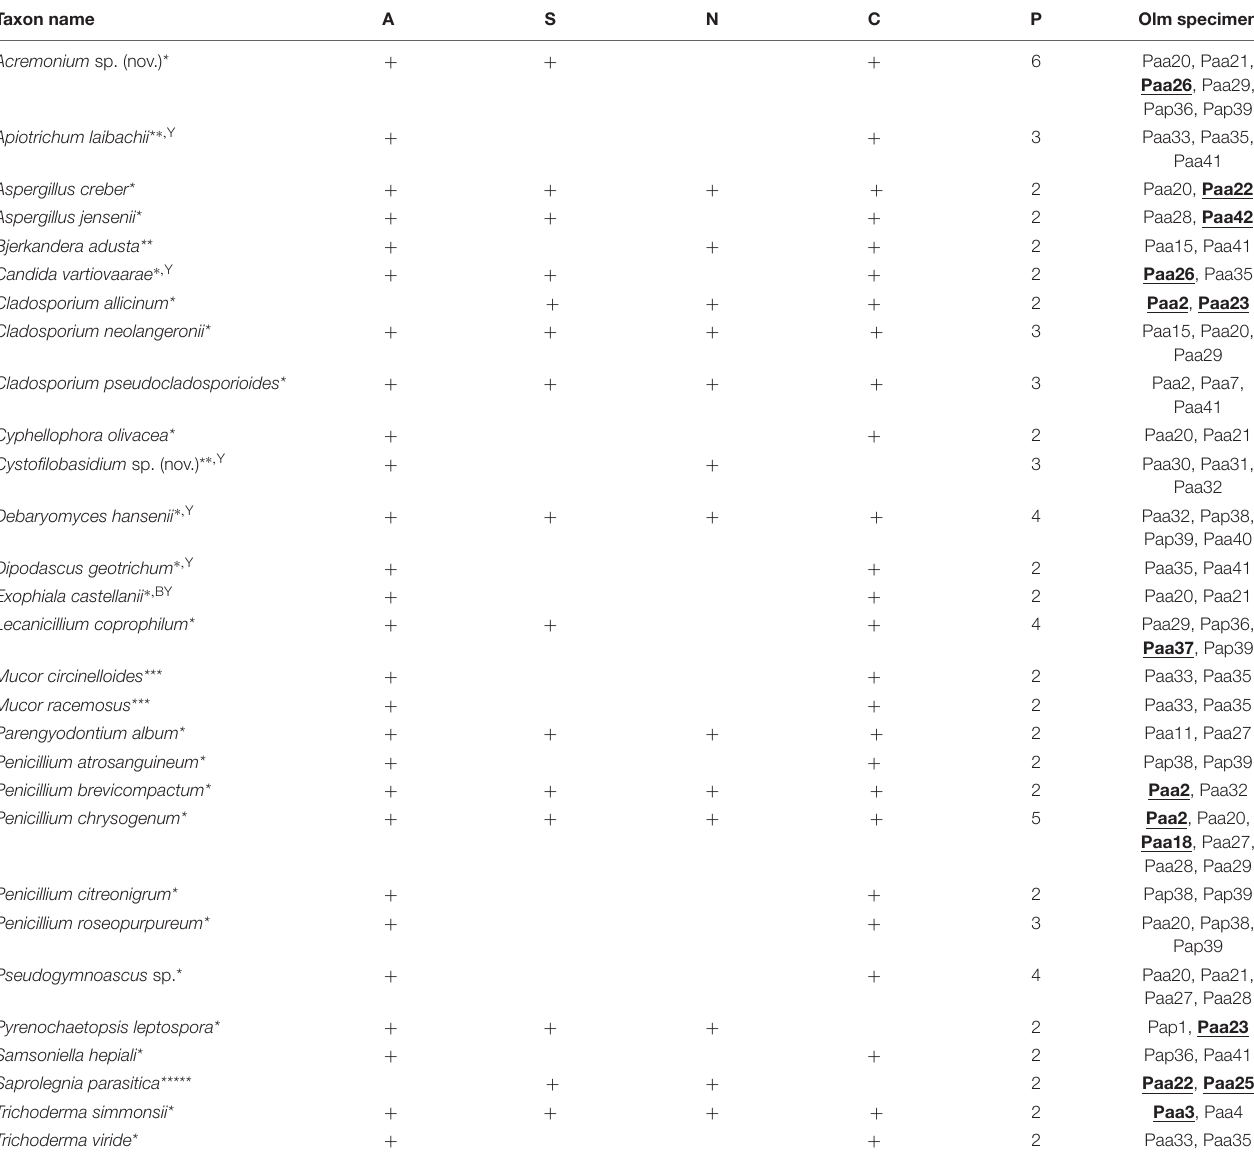
TABLE 2 | List of fungal species isolated from at least two sampled olm specimens: asymptomatic animals (A), symptomatic animals (S), natural cave environment (N), captivity (C), number of olm specimens from which fungal strains were isolated (P). Taxon